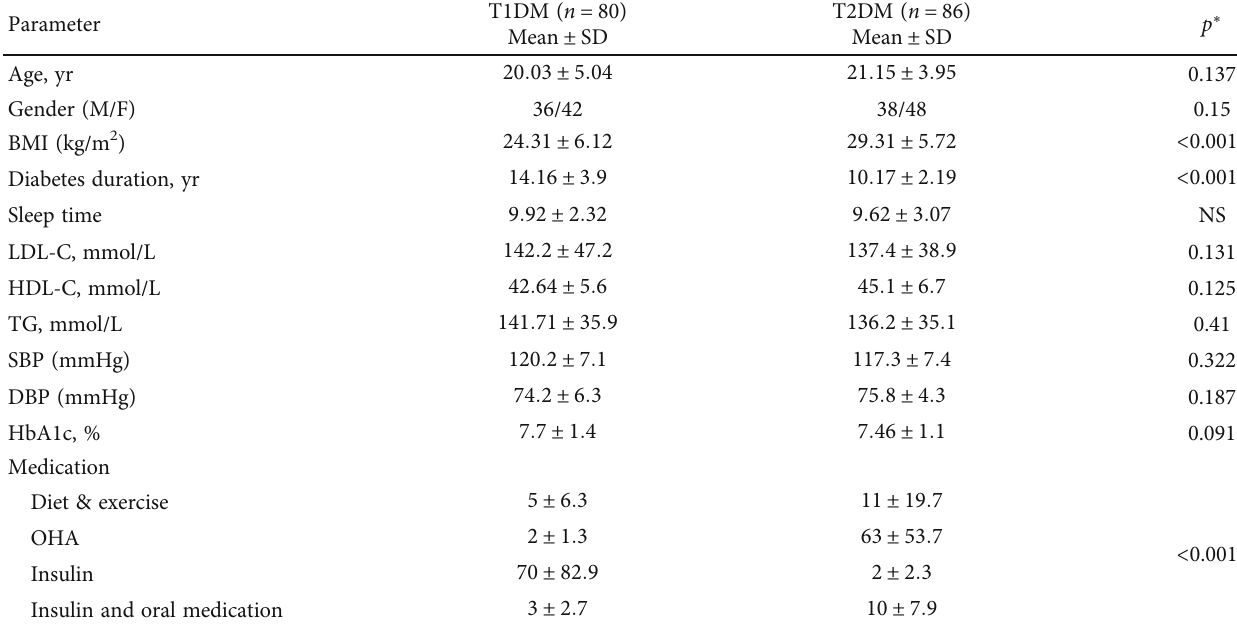
Table 1: The di ff erence in demographic and clinical parameters of both